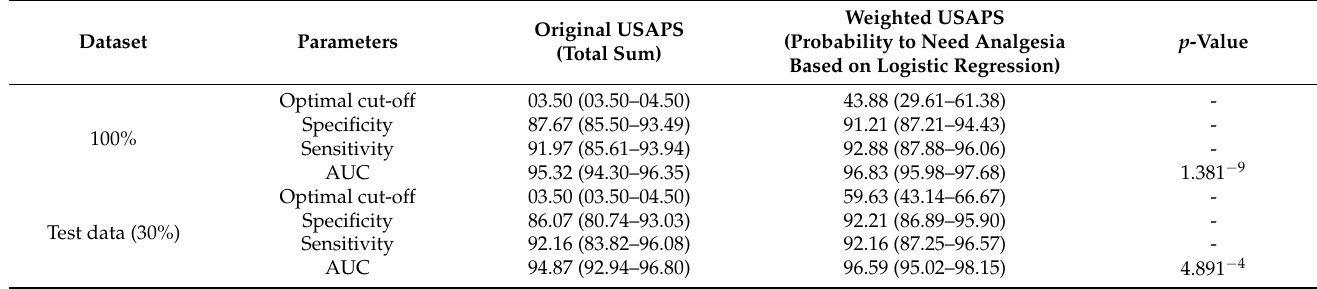
Table 2. Optimal cut-off, specificity, sensitivity, and area under the curve from receiver operating characteristic curve of the original USAPS and weighted USAPS from multilevel binomial logistic regression algorithm (no event = no indication of analgesia; event = indication of